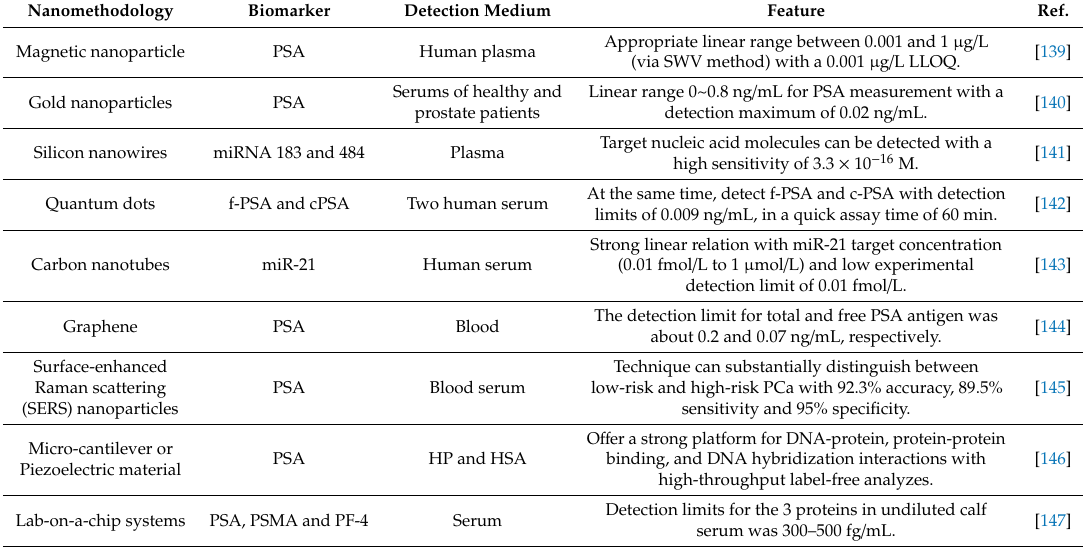
Table 1. Nano-methodology approaches used in the biosensing of prostate cancer biomarkers. Nanomethodology Biomarker Detection Medium Feature Ref. Magnetic nanoparticle PSA Gold nanoparticles Silicon nanowires Quantum dots Carbon nanotubes miR-21 detection limit of 0.01 fmol / L. Graphene PSA Surface-enhanced Technique can substantially distinguish between Raman scattering PSA low-risk and high-risk PCa with 92.3% accuracy, 89.5% sensitivity and 95% specificity. O ff er a strong platform for DNA-protein, protein-protein Micro-cantilever or PSA HP and HSA binding, and DNA hybridization interactions with Piezoelectric material high-throughput label-free